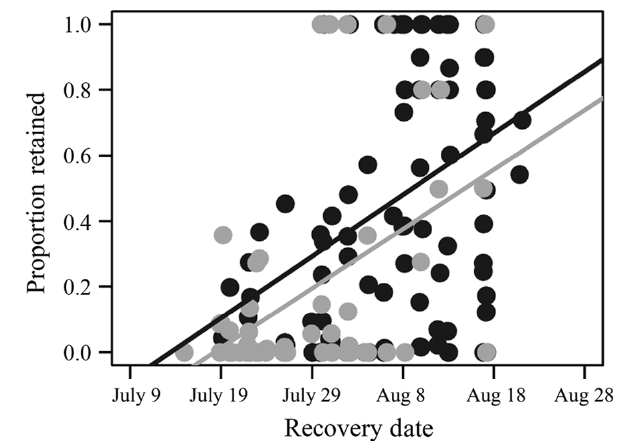
Fig. 4. Proportion of eggs retained by natural-origin (grey) and hatchery-produced (black) female chum salmon